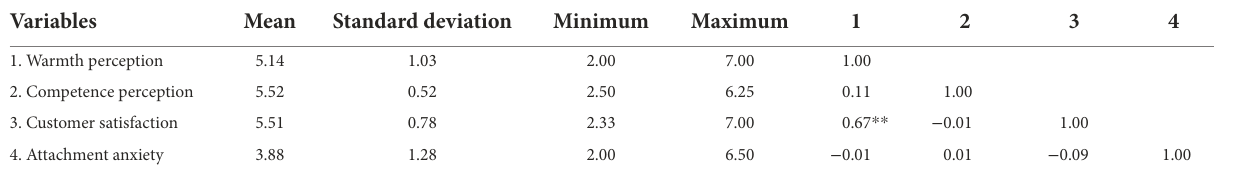
TABLE 4 Descriptive statistics and correlations for Study 3.